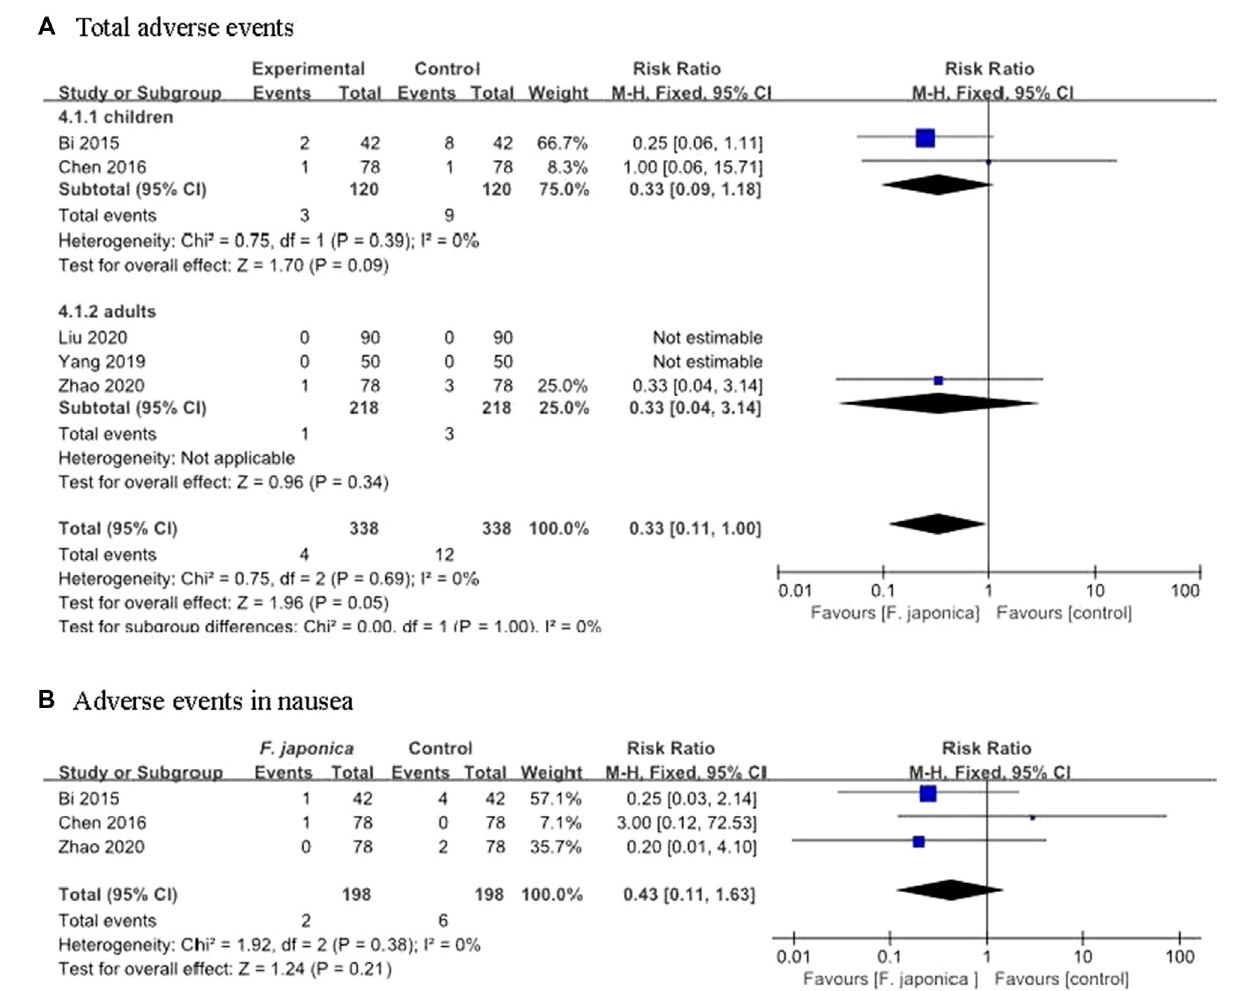
FIGURE 4 | Adverse events from the including trials (A) . Total adverse events (B) . Adverse events in nausea.